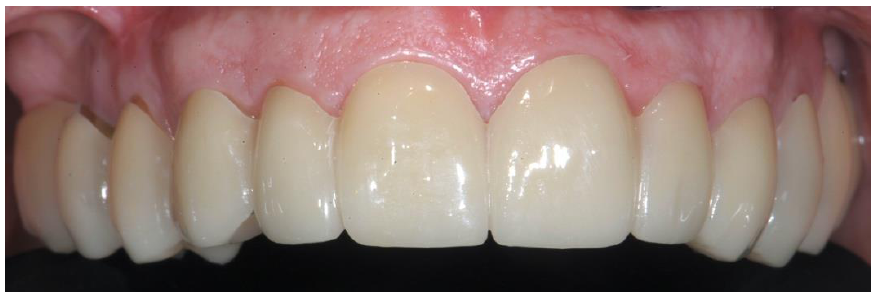
Figure 4. Case 1—The DEFS, made of acetal resin.